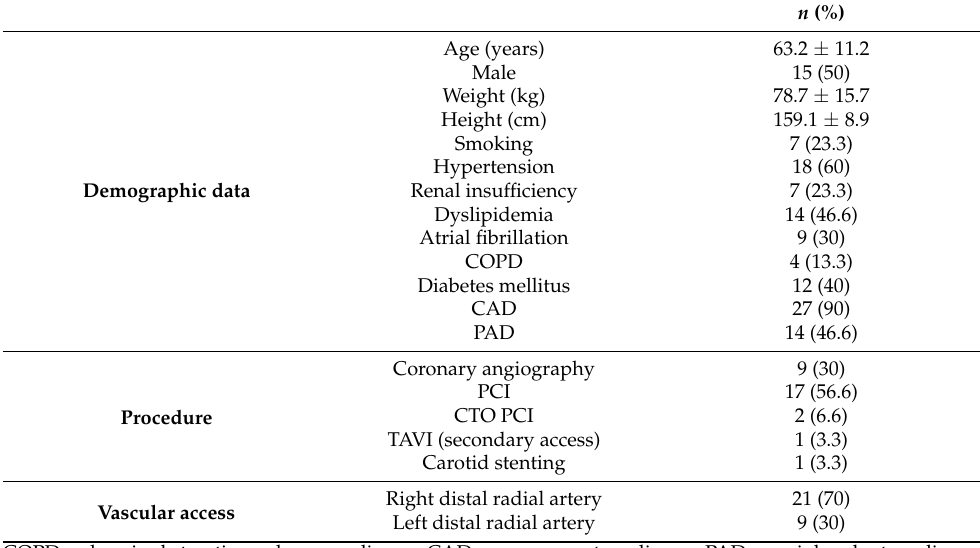
Table 1. Demographic and clinical